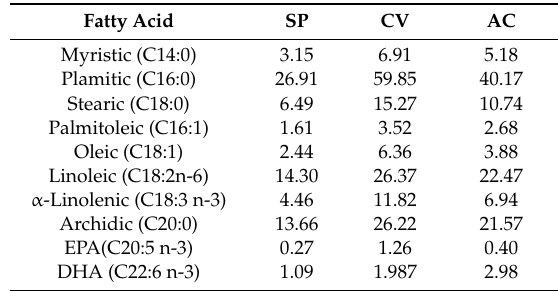
Table 2. Concentrations of fatty acids (mg / g dried powder) in studied microalgae ( Spirulina platensis (SP), Chlorella vulgaris (CV), and Amphora co ff eaformis (AC)).